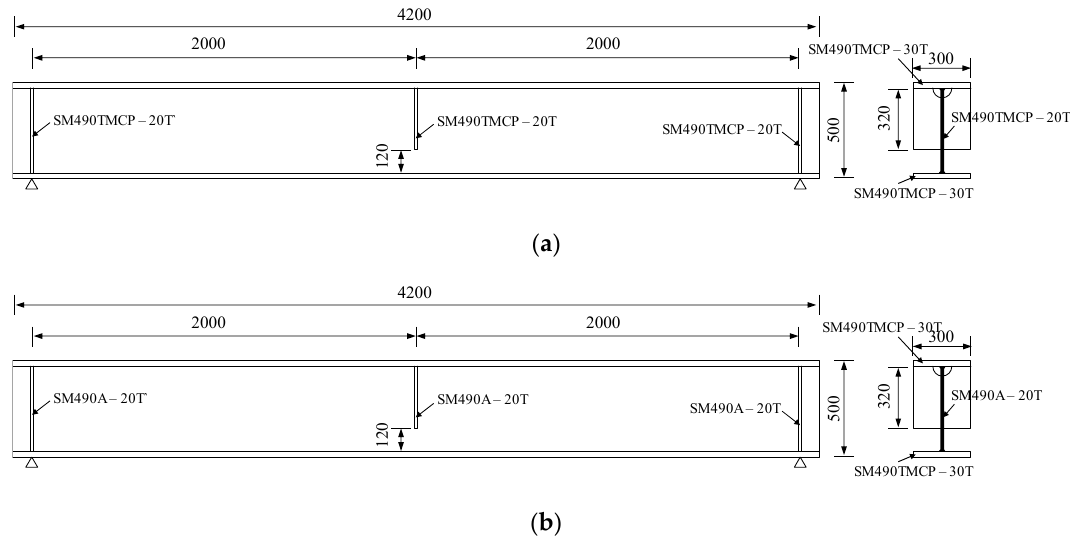
Figure 8. Flexural specimen detail. ( a ) Specimen TM (SM490TCM for web); ( b ) specimen TA (SM490A for web).